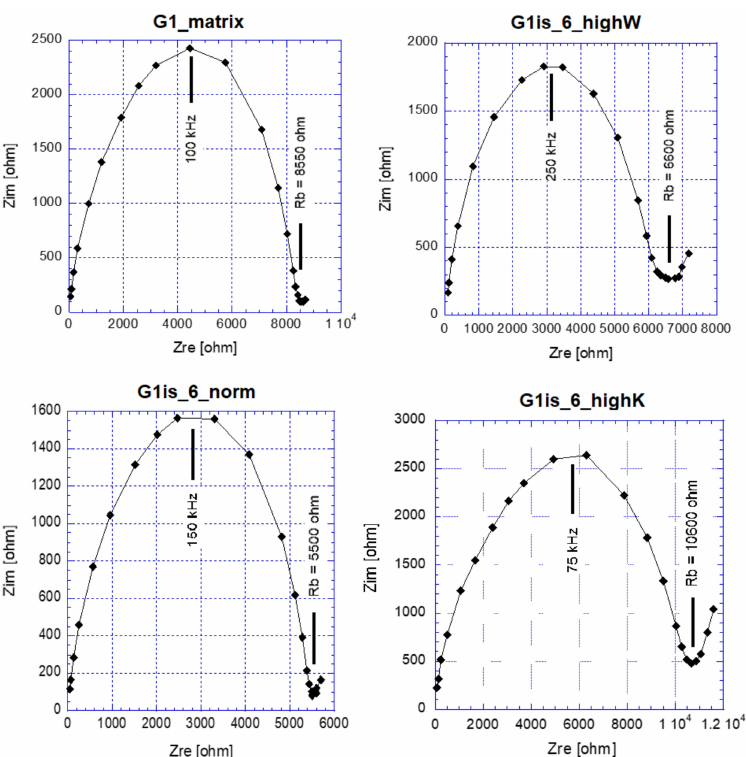
Figure 17. Nyquist plots of disk samples of G1_matrix, G1is_highW, G1is_highK and G1is_norm.